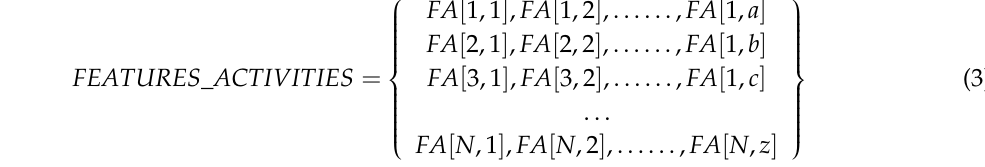
Algorithm 3: Algorithm for Determining Objects from the Reference Frames